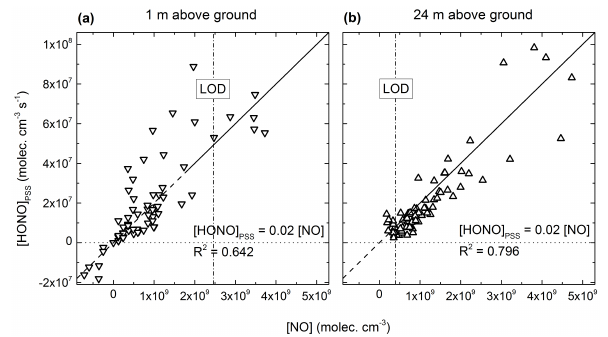
Figure 4. The PSS concentration of HONO, [HONO] PSS , at 1m measurement height (a) and at 24m measurement height (b) is plot- ted against the concentration of NO at the corresponding heights. The dash-dotted vertical line reflects the lower limit of detection (LOD) for each NO measurement. The linear fit using a fixed slope of 0.02 and no offset leads to a reasonable correlations between [HONO] PSS and [NO] in both cases.